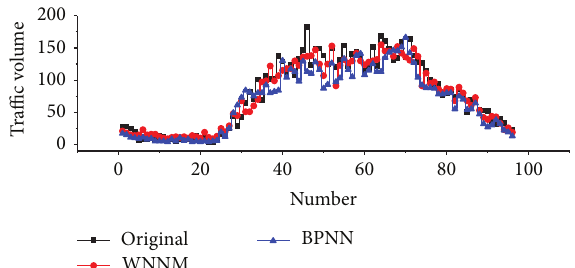
Figure 6: Traffic volume in test set and its prediction by WNNM and